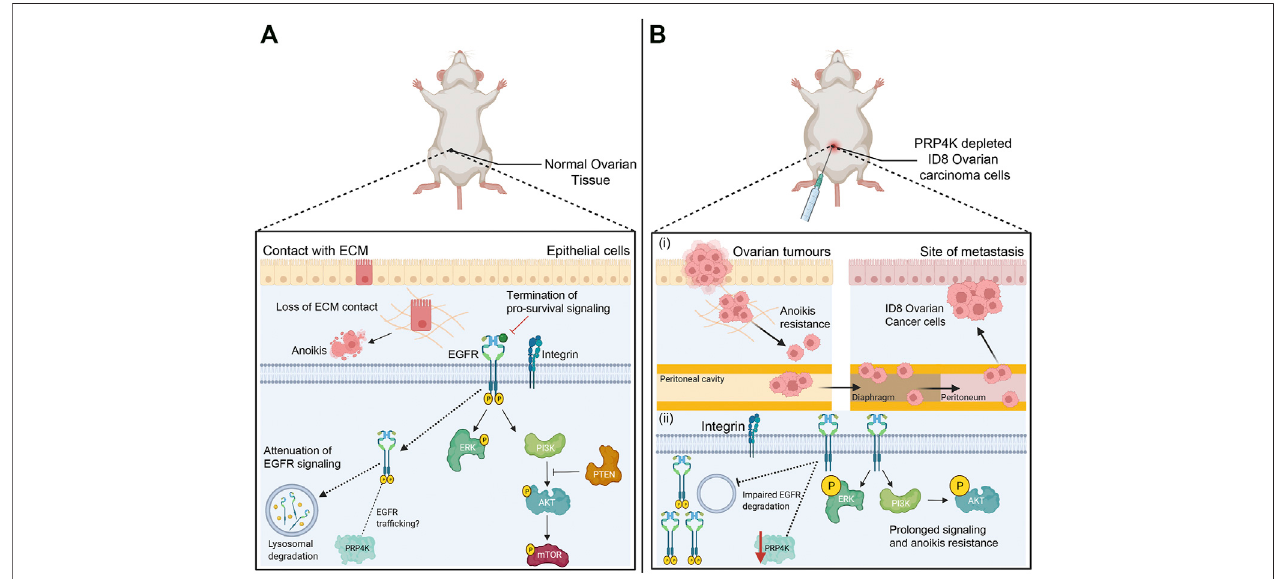
FIGURE3 | Anoikis pathway isa barrier against metastasis and loss ofPRP4K triggersanoikis resistance by promoting pro-survival signaling. (A) Anoikis pathway induces cell death (apoptosis) after cell detachment from the ECM (extracellular matrix) to prevent adherent-independent cell growth and attachment. Pro-survival pathwaysthatregulatecellsurvivalandproliferationareterminatedonceintegrinsdisengagefromtheECM.Epithelialgrowthfactorreceptor(EGFR)signalingisonesuch pathway, and detachment triggers EGFR traf fi cking to the lysosome and its degradation to attenuate of EGFR signaling; a feedback loop that is dependent upon the presence ofPRP4K. EGFR degradation consequentlyresults indecreased ERK and PI3K/AKT/mTOR kinase activation to further suppress pro-survival signaling. In addition, PTEN (phosphatase-tensin) acts as a tumour suppressor to inhibit growth by negatively regulating the PI3K/AKT/mTOR pathway. (B) The depletion of PRP4K leads to anoikis resistance and cell survival in xenotransplanted mouse ID8 ovarian carcinoma cells under detached growth conditions. PRP4K depleted ID8 cells disseminatewithintheperitonealcavitywhichthenpromoteanchorage-independentgrowthandmetastasisinthediaphragmandperitoneum.LossofPRP4Kresultsin impaired degradation ofEGFR, whichinturnresultsinsustainedERK andPI3K/AKT kinaseactivationtopromotecellsurvivalandanoikisresistance inPRP4K-depleted cells. Elements of this fi gure were created with